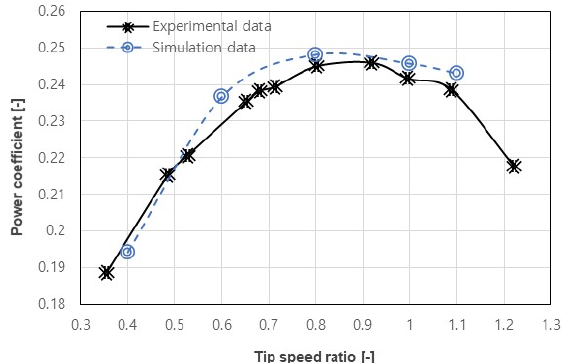
Figure 3. Test data comparison for examining the CFD analysis results.